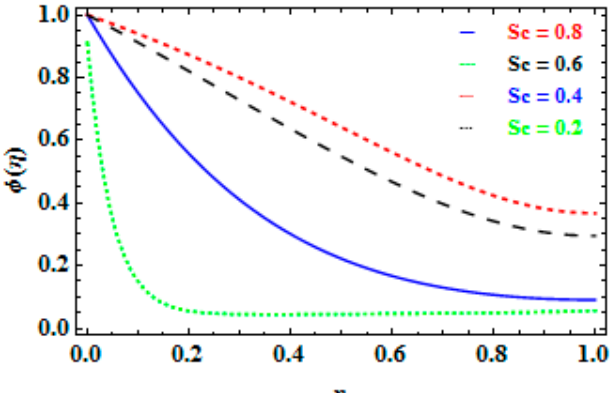
Figure 18. Influence of β on φ ( η ) .